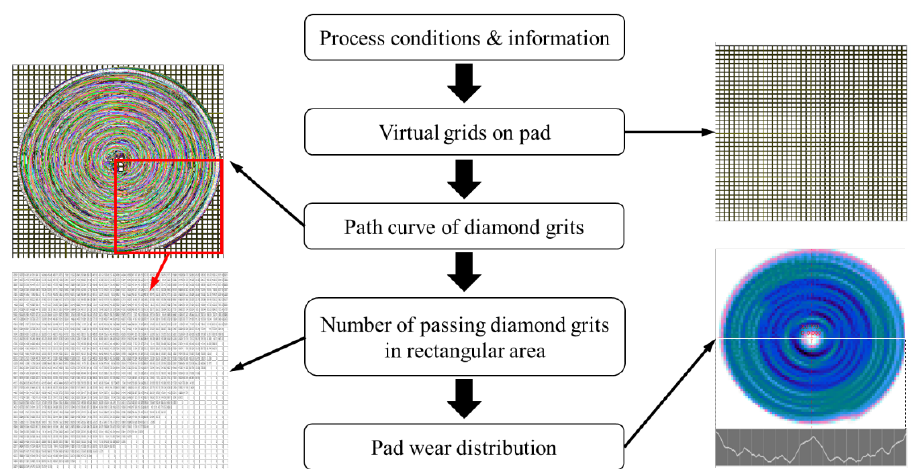
Figure 4. Flowchart of pad wear profile simulation.